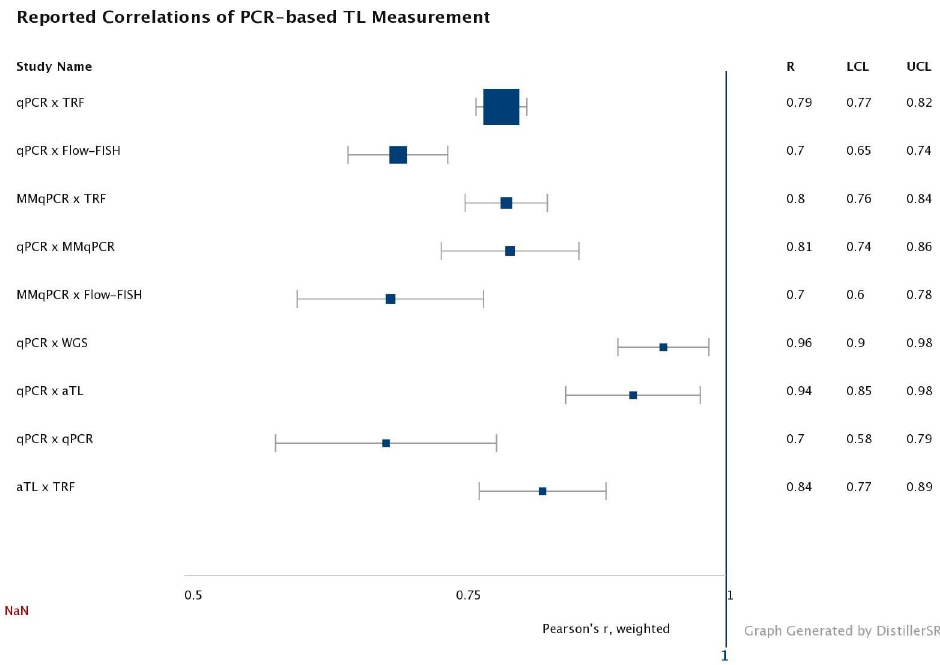
Fig 4. Weighted average correlation (Pearson’s r) and 95% CI for each method compared with qPCR, MMqPCR, or aTL. LCL: lower confidence limit. UCL: upper confidence limit. The point sizes for each comparison are weighted by the number of individual papers with that